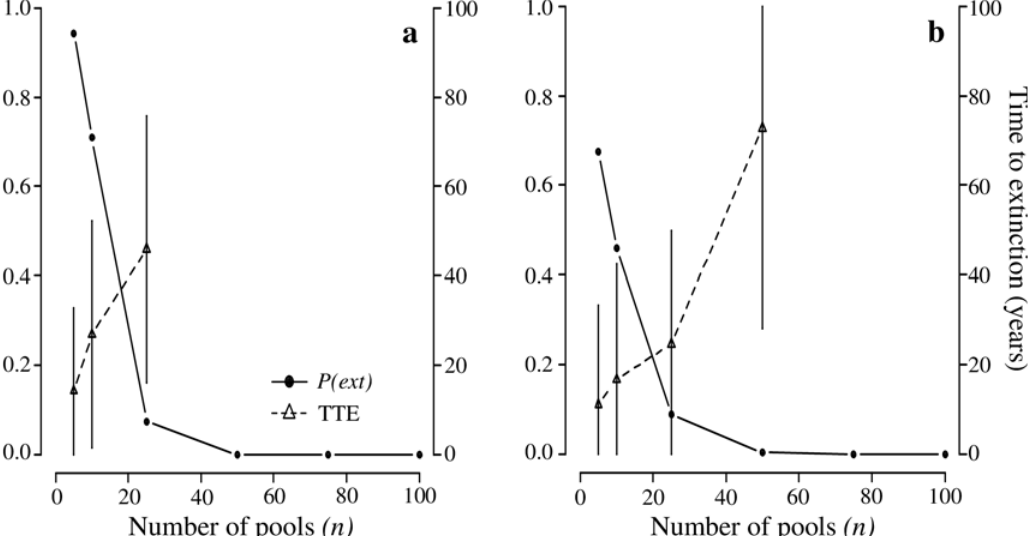
Fig 1. The probability of quasi-extinction ( (P(ext) ) and the mean time to extinction (TTE) for wood frog metapopulations. Simulation scenarios consisted of combining estimated parameter distributions from (a) Patuxent National Research Refuge, Maryland, USA and (b) Rock Creek Park, Washington, DC, USA with different numbers of vernal pools ( n ): 5, 10, 25, 50, 75, and 100 pools. One thousand iterations were run for each scenario. Quasi- extinction occurred when no pools produced metamorphic wood frogs for two consecutive years. Quasi-extinction was not observed in simulations involving > 50 pools. Error bars for TTE represent 1 standard deviation.